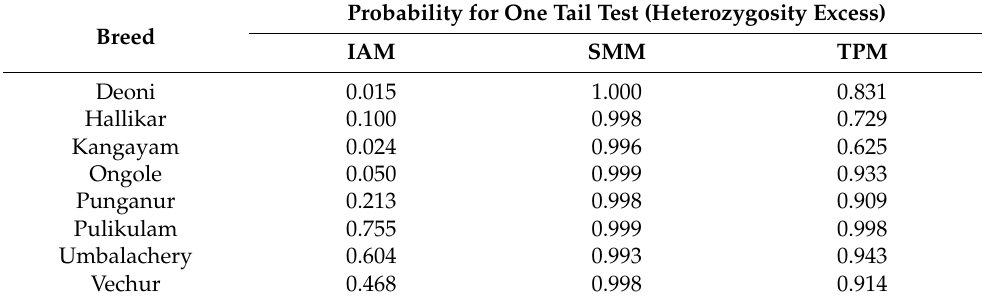
Table 4. Wilcoxon sign rank test to evaluate zebu cattle breeds for mutation drift equilibrium under different